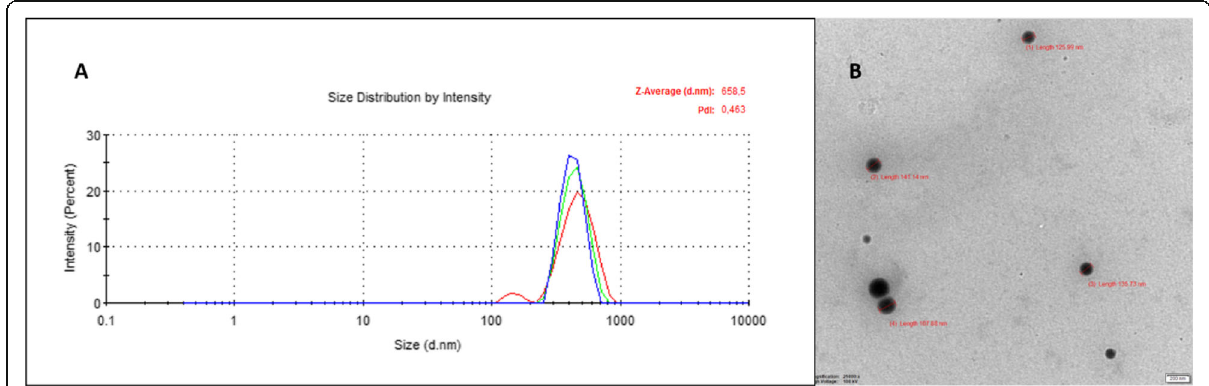
Fig. 2 Particle size, polydispersity index, and zeta potential of farnesol-loaded PLGA